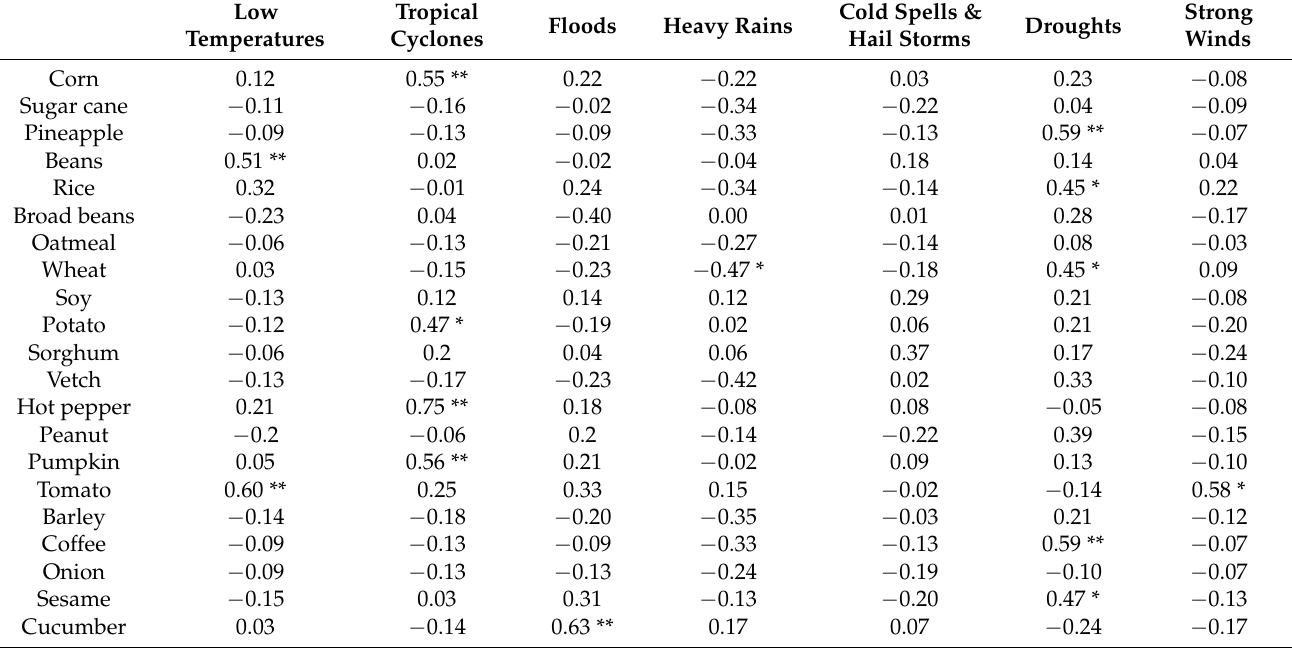
Table 2. Correlation between damaged crop areas and hydrometeorological hazards from 2001 to 2020 in the State of